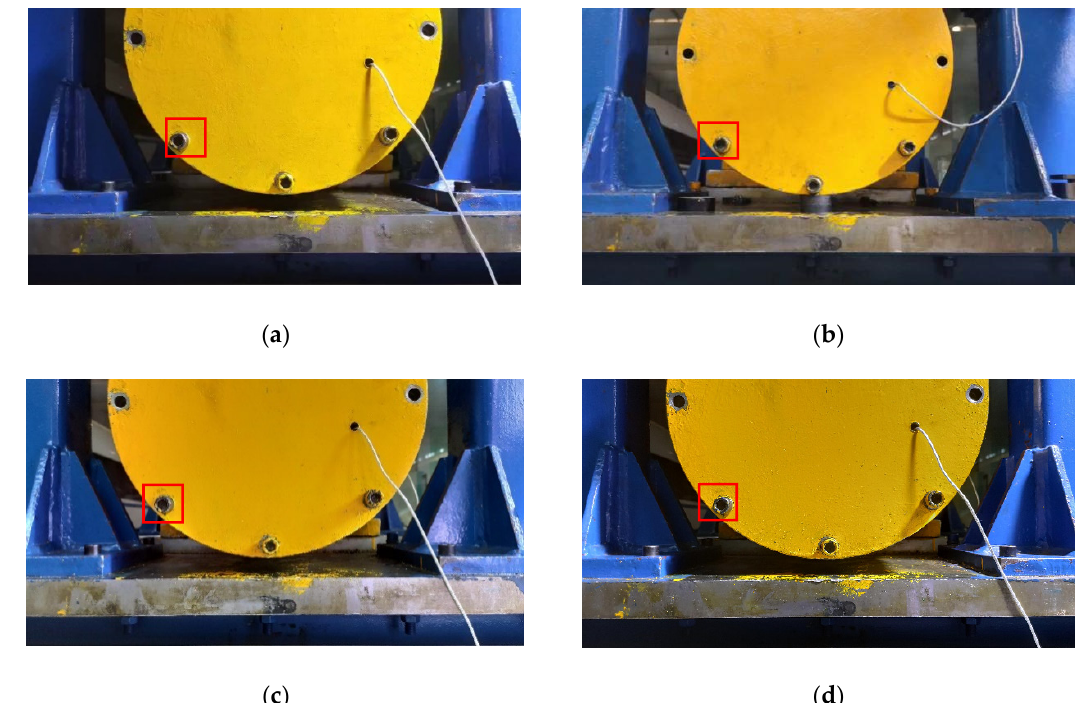
Figure 11. Template matching effect image under different illumination conditions (as Figure 9): ( a ) image under strong supplementary light source condition; ( b ) image under strong natural light conditions; ( c ) images under low natural light conditions; ( d ) image under weak supplementary light source